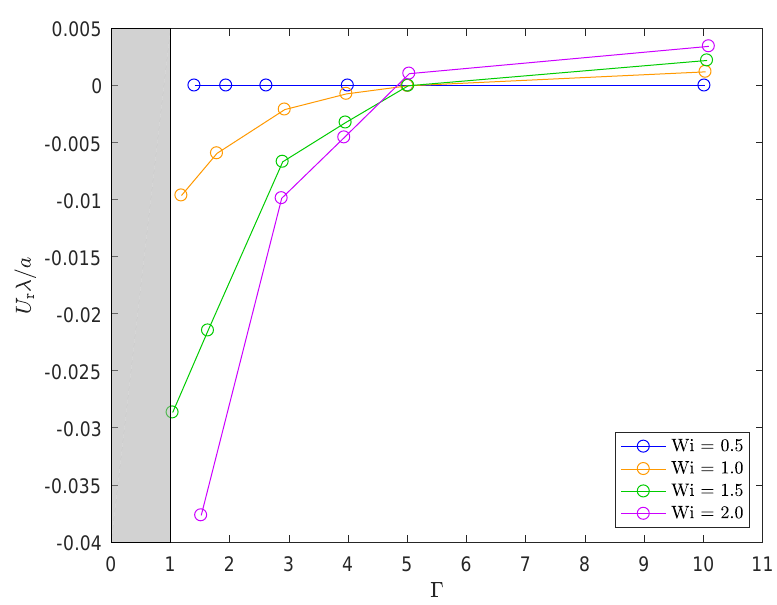
Figure 6. Migration velocity of the particle at different positions from the inner cylinder without sedimentation and varying shear Weissenberg number at time t / λ = 10. The shaded area indicates the inaccessible region.